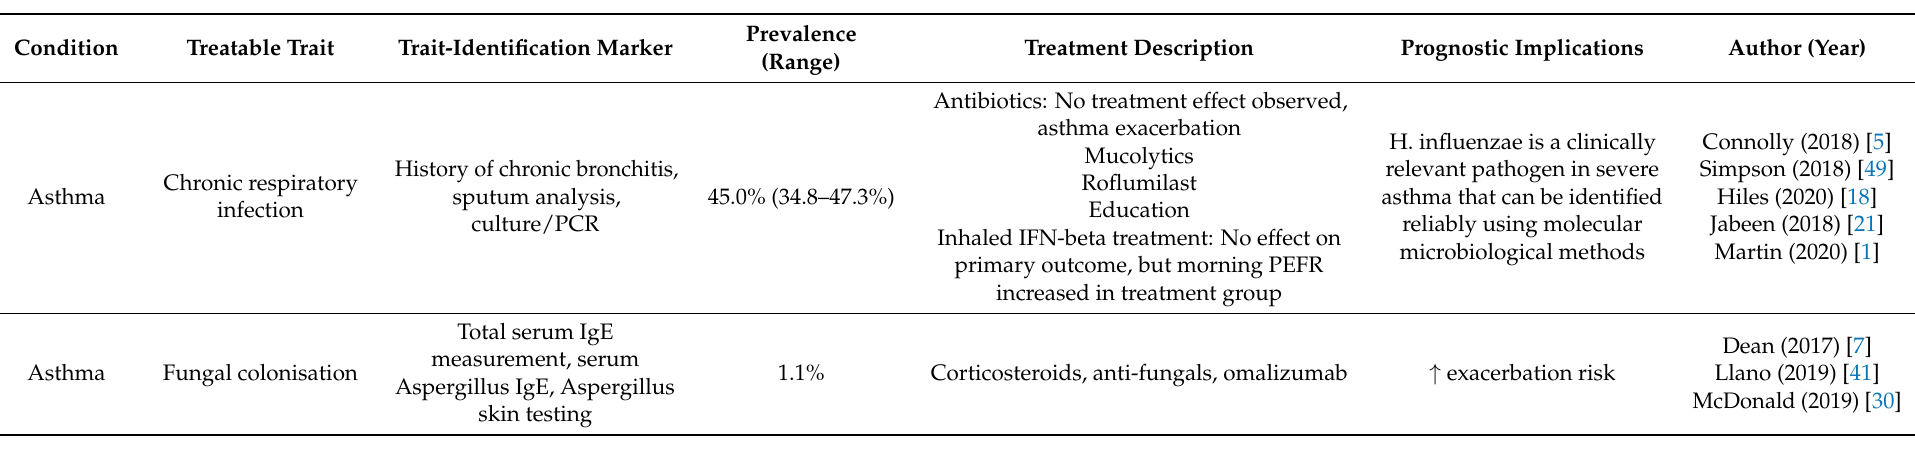
Table 5. Overview of microbiological treatable